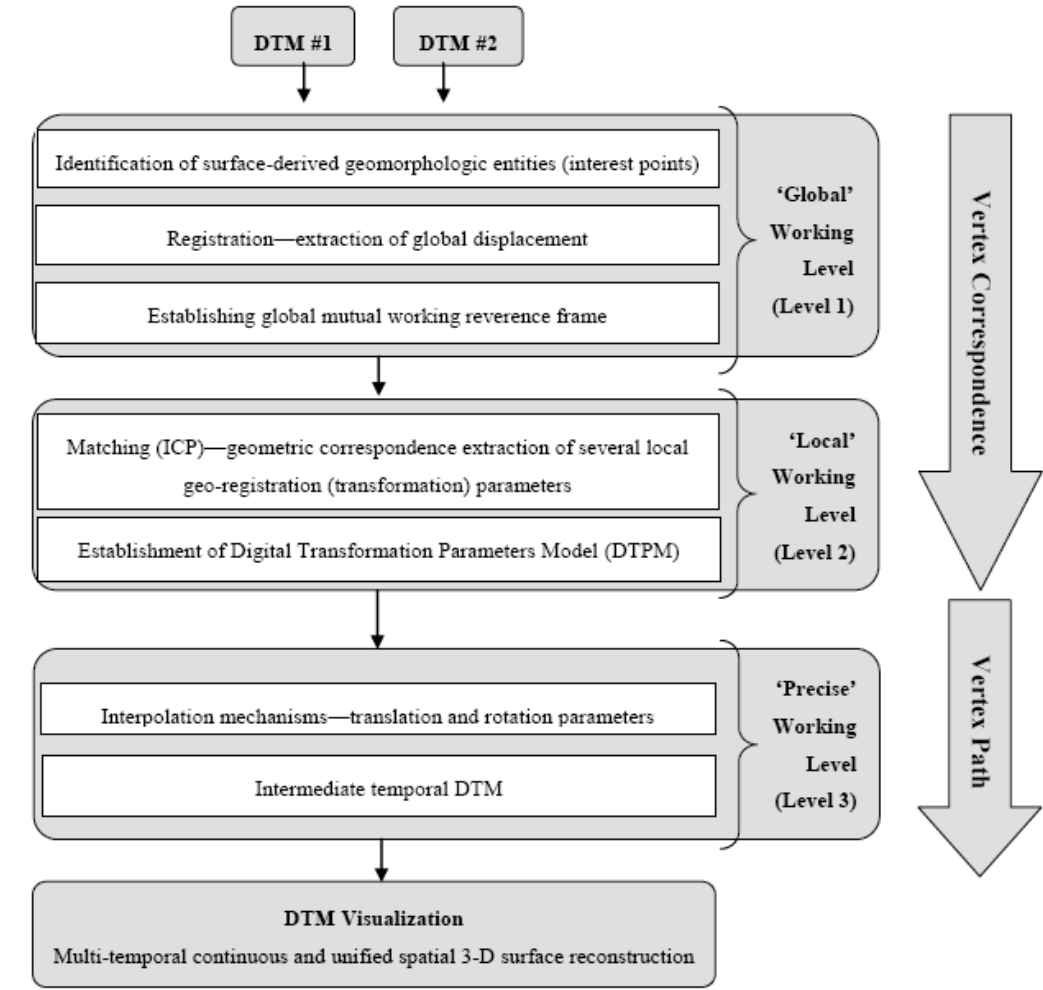
Figure 4. Workflow of the hierarchical modelling mechanism and its main stages. DTM, Digital Terrain